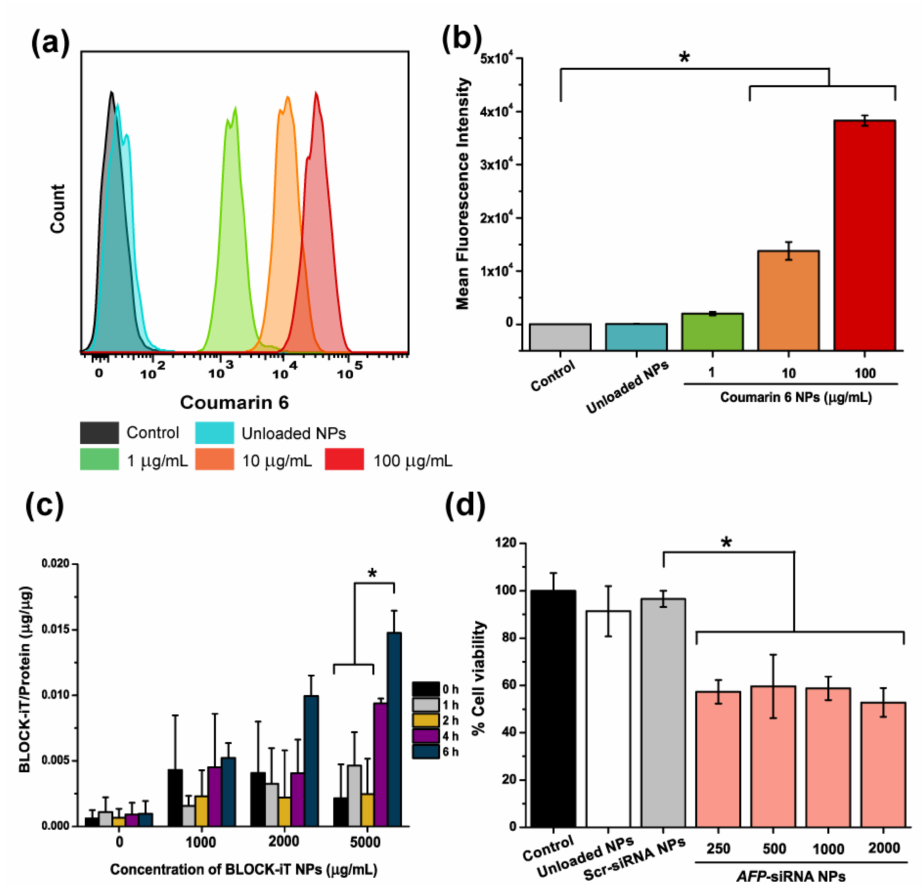
Figure 3. Cellular internalization of siRNA NPs was investigated. ( a ) Histogram analyzed by flow cytometry demonstrated cellular internalized NPs at 1 h. ( b ) Mean Fluorescence Intensity of internalized NPs at different concentrations for 1 h. ( c ) Different concentrations of BLOCK-iT NPs were treated with HepG2 cells at different incubation times. ( d ) The percentage of HepG2 cell viability at different concentrations of AFP -siRNA NPs for 48 h. Untreated HepG2 cell, 2000 µ g/mL of unloaded NPs, and Scr-siRNA NPs were used as controls. Significance was set at p -values of p < 0.05 and indicated with an asterisk